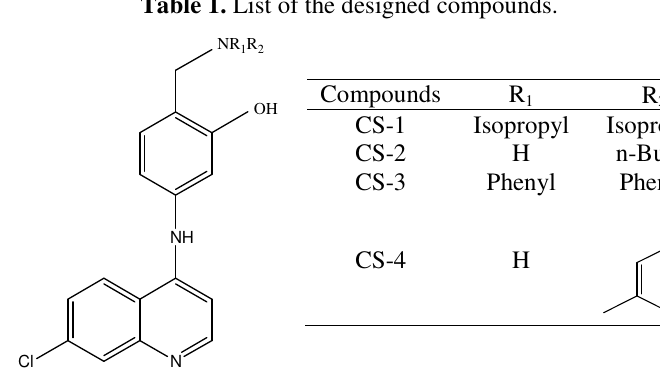
Table 1. List of the designed